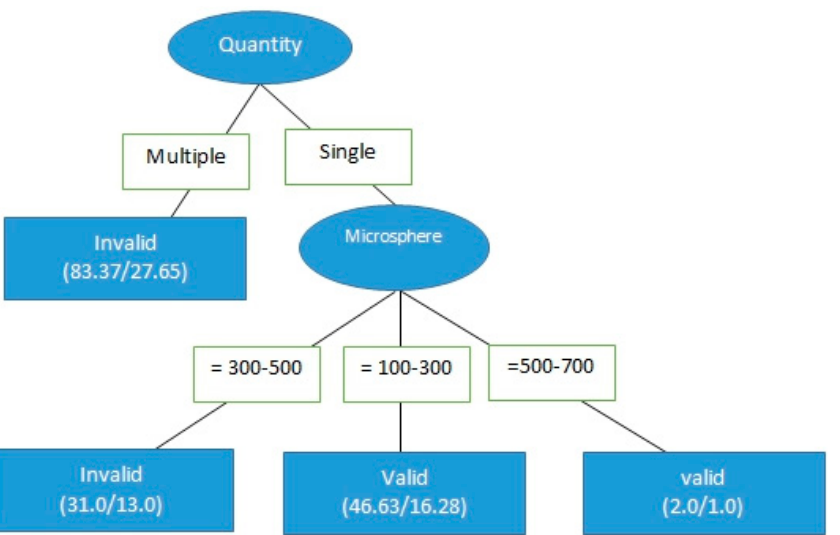
Figure 4. Decision tree classification of the effectiveness of DC bead TACE with single-sized micro- spheres on single tumors.